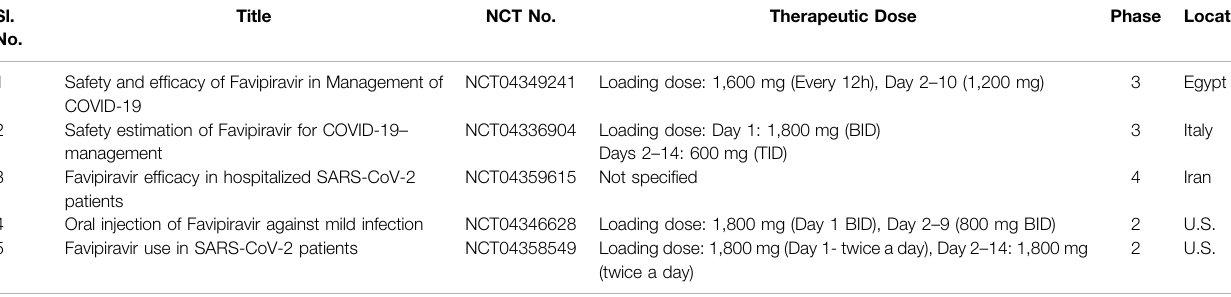
TABLE 4 | Running clinical trial studies for validation of Remdesivir (https://clinicaltrials.gov/ct2/results). Sl. No.